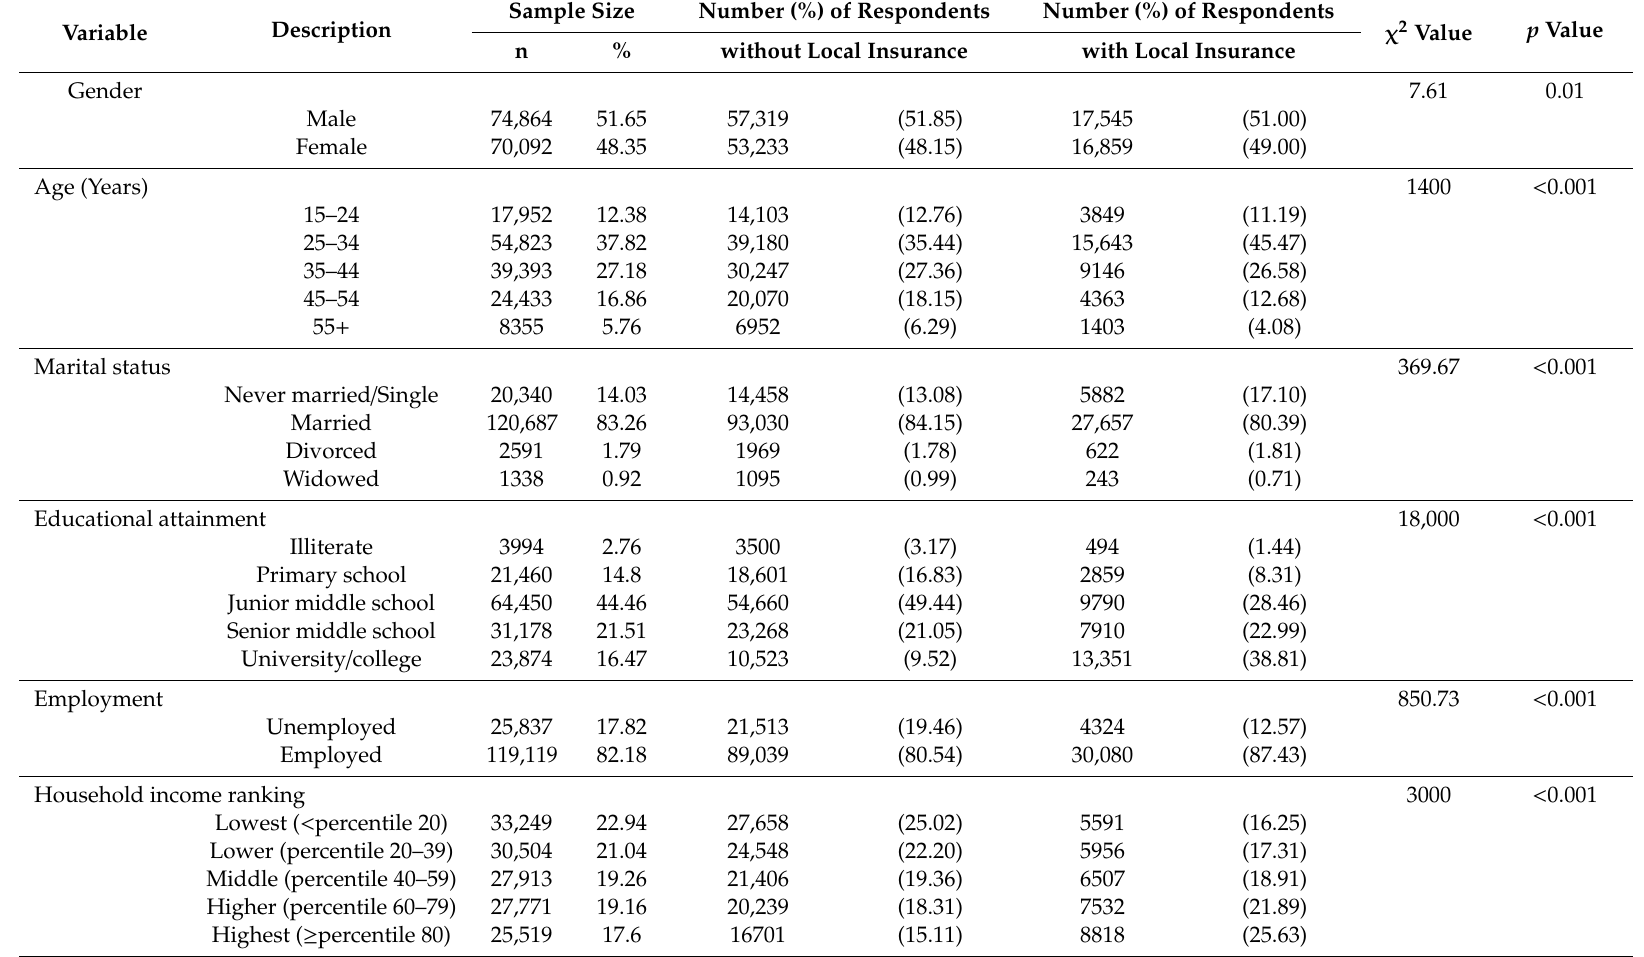
Table 1. Characteristics of respondents with and without local social health